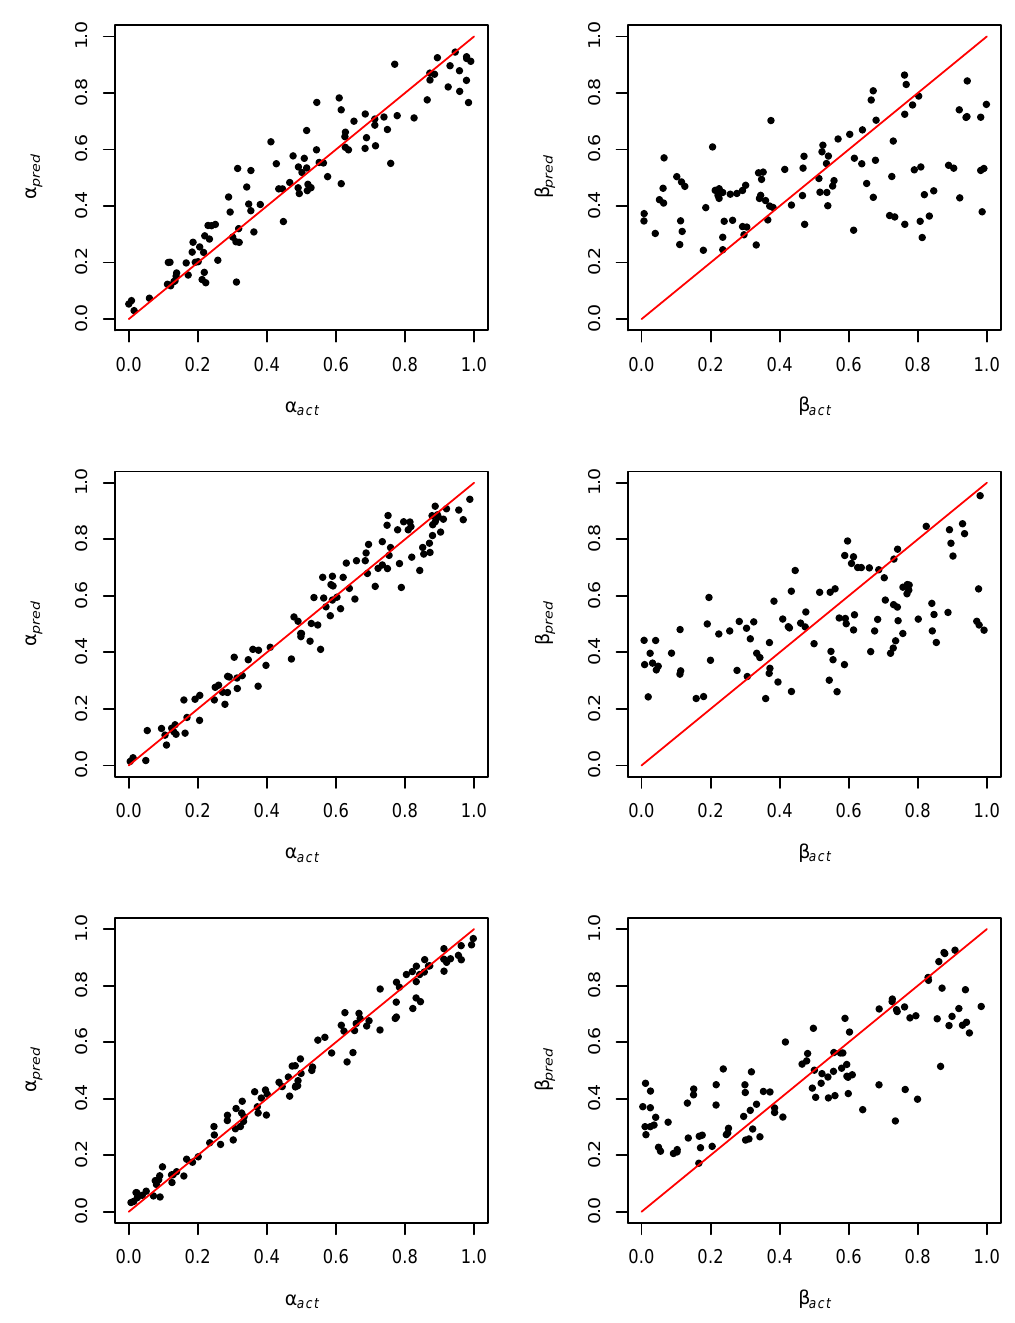
Figure 4: Comparisons of actual values of α and β with the predicted values by the ABC procedure. The three rows of plots rep- resent sample sizes of 100 , 250 , and 1000 ,